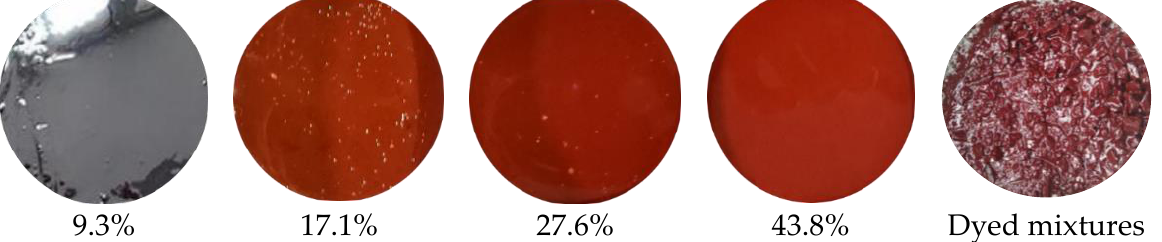
Figure 1. Visualization of dyed bitumen with different contents of iron oxide.